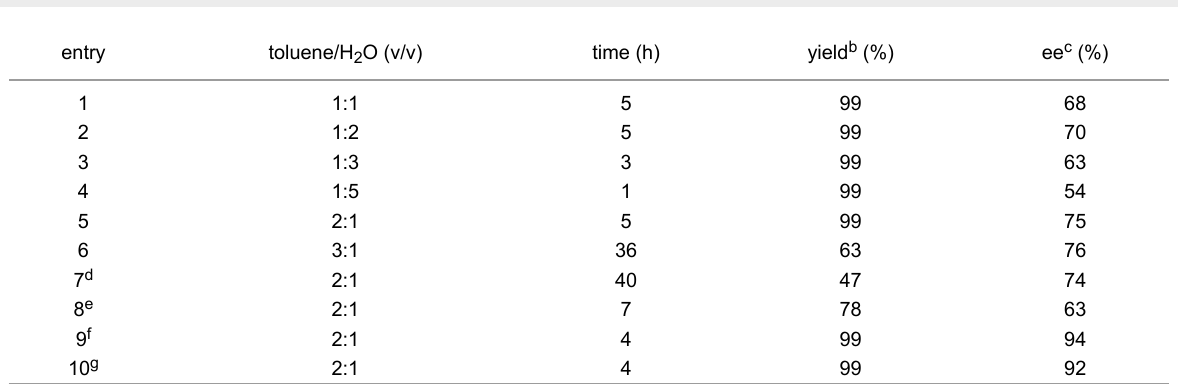
Table 2: Optimization of reaction conditions.